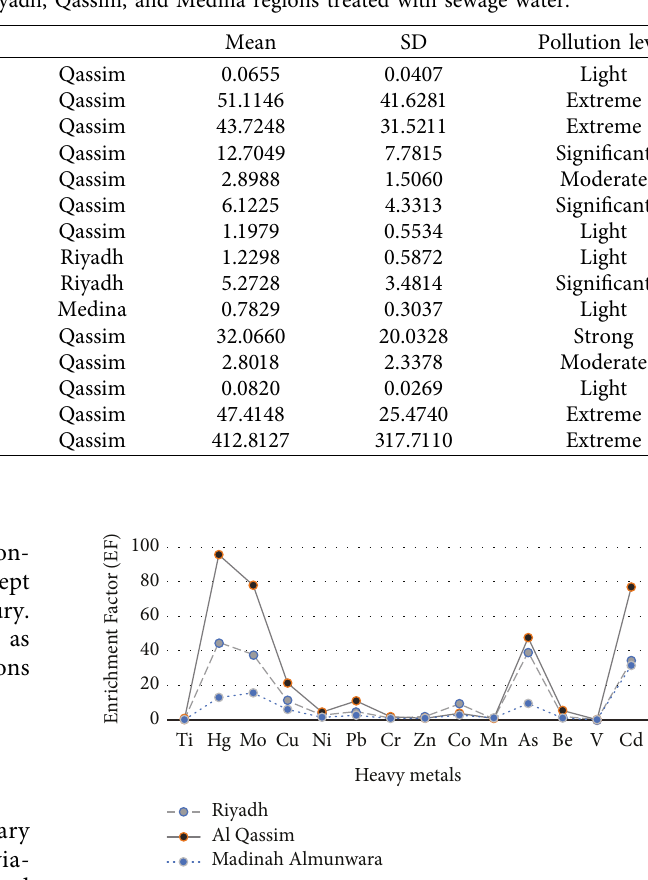
Figure 2: EF value for heavy metals in soil samples collected from Riyadh, Qassim, and Medina